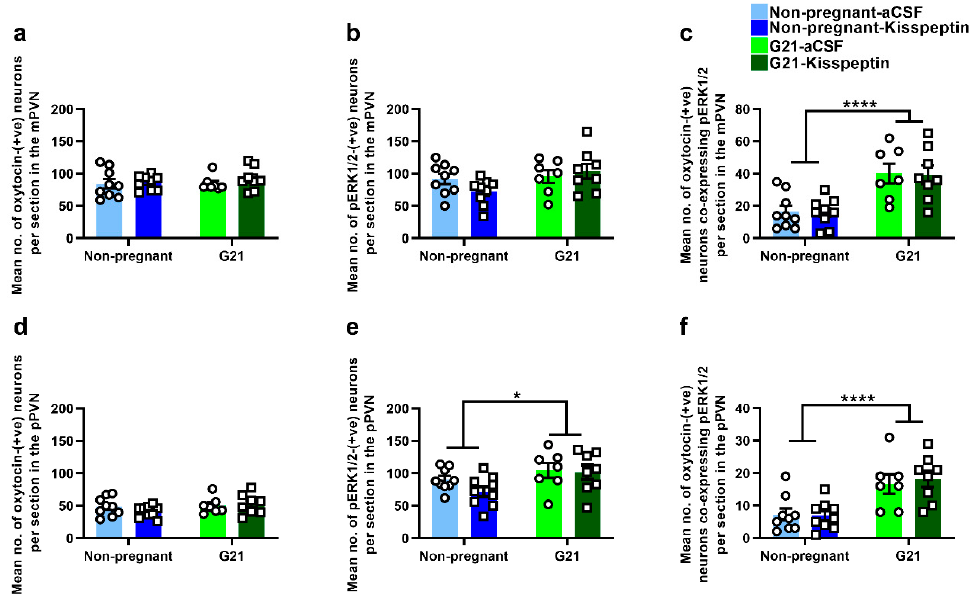
Figure 2. Kisspeptin does not affect pERK1/2 expression in mPVN or pPVN oxytocin neurons of non-pregnant and G21 rats. Mean ( ± SEM) number of ( a ) oxytocin-positive neurons (RS: F (1,1) = 0.282, p = 0.599; T: F (1,1) = 0.668, p = 0.420; RS × T: F (1,2) = 0.221, p = 0.641, two-way ANOVA), ( b ) pERK1/2- positive neurons (RS: F (1,1) = 3.82, p = 0.060; T: F (1,1) = 0.431, p = 0.516; RS × T: F (1,2) = 2.35, p = 0.136, two-way ANOVA) and ( c ) oxytocin-positive neurons co-expressing pERK1/2 (RS: F (1,1) = 26.27, p < 0.0001; T: F (1,1) = 0.028, p = 0.866; RS × T: F (1,2) = 0.0006, p = 0.980, two-way ANOVA) per section in the mPVN of non-pregnant rats and G21 rats after ICV administration of aCSF/kisspeptin (2 µ g in 2 µ L). Mean ( ± SEM) number of ( d ) oxytocin-positive neurons (RS: F (1,1) = 1.95, p =